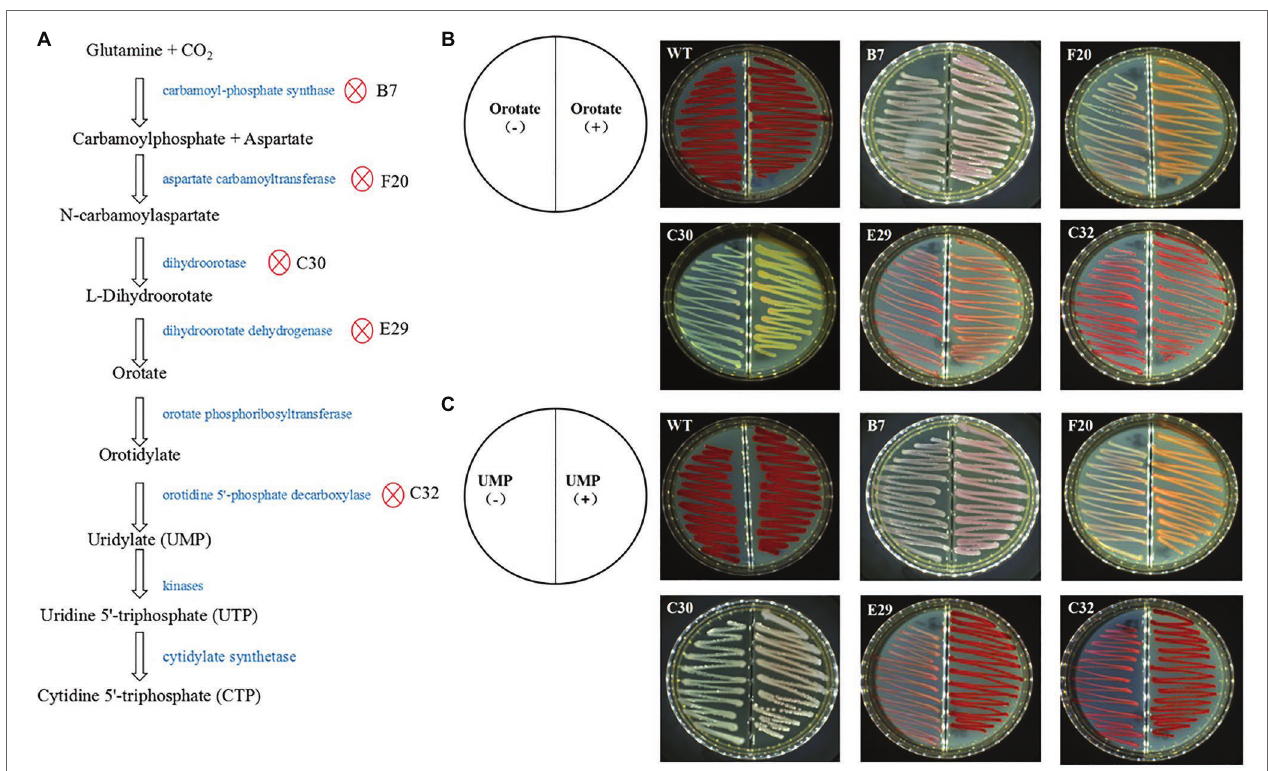
FIGURE 2 | Functional certification of prodigiosin production in the mutant genes involved in pyrimidine nucleotide biosynthesis. (A) Proteins of the pyrimidine nucleotide biosynthesis pathway and the proteins, in which the encoding genes were inserted by the Tn5 transposon. (B) Rescue effect on prodigiosin production by adding orotate into the medium. The prodigiosin-producing ability can be partially rescued for B7, F20, C30, and E29 but not for C32. (C) The rescue effect on the prodigiosin production of UMP for the mutant strains. Prodigiosin producing ability can be partially rescued for B7, F20, C30, E29, and C32. The concentration of orotate and UMP was 0.1 g/L; the incubation conditions of the strains were 28 ° C for 36